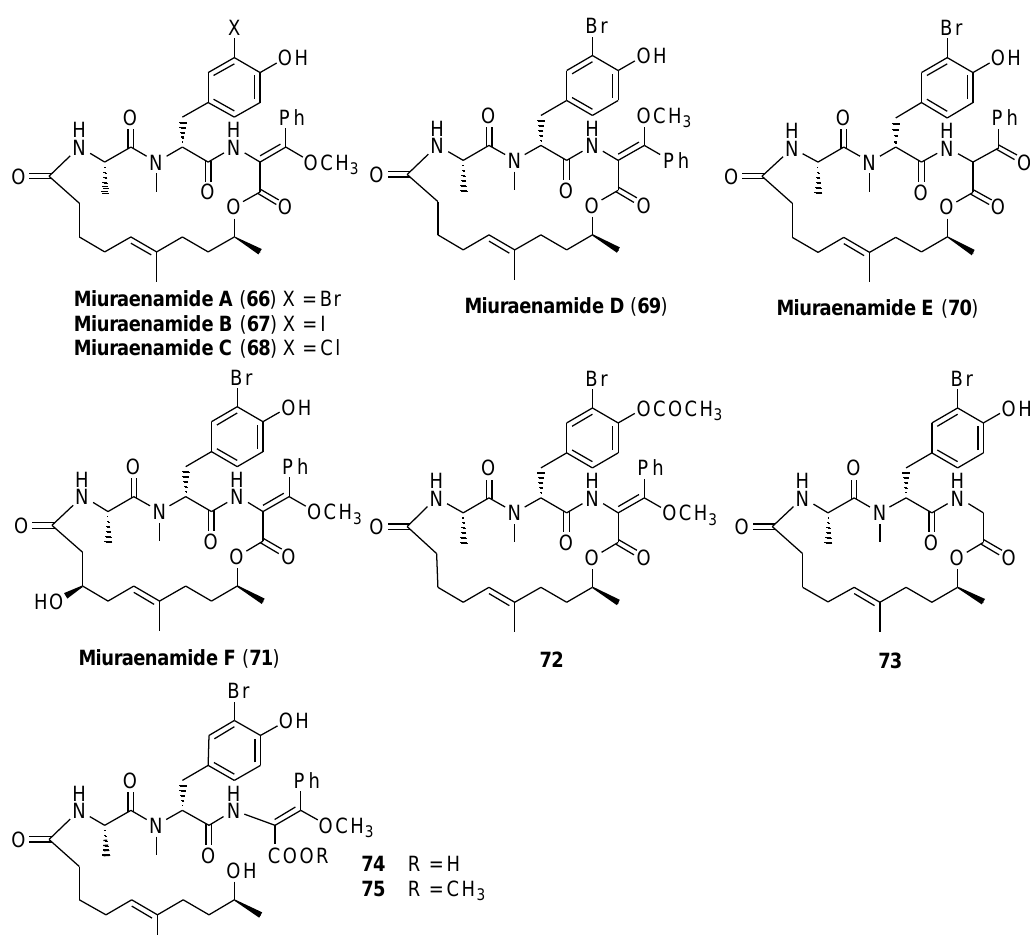
Figure 16. Structures of miuraenamides A-F ( 66 – 71 ) and related derivatives ( 72 – 75 ).